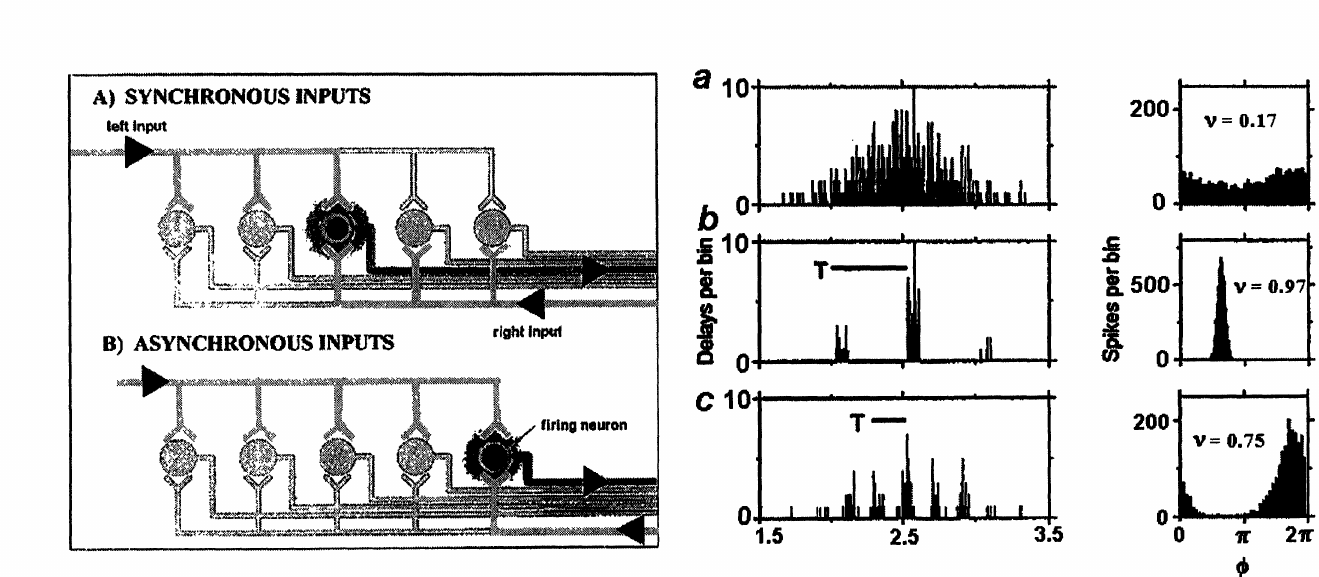
Fig. 2: Detecting submillisecond coincidences in the nucleus laminaris of the barn owl. The principle of the time coding to space coding converter implemented in this nucleus is sketched in the left panel. Synchronous inputs from the right and left ear lead to the discharge of the neurone in the middle of the row. The greater the interaural delay, the farther from the centre of the row the discharging neurone, for which the input interaural aural delay is exactly compensated by the differential conduction delays in the transmitting fibers. The panel on the right illustrates a possible mechanism for achieving a very fine coincidence discrimination, despite the anatomically predicted spreading of the signal in the terminal axonal arborisations in the nucleus laminaris afferents. It is assumed that a subset of synapses are selected according to their common phase by a Hebbian mechanism of plasticity. (Modified from Gerstner et al,